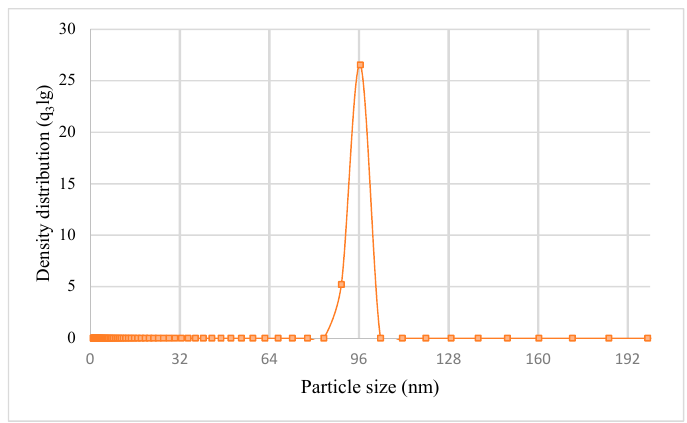
Figure 2. Particle size distribution of 1.0 M ethanolic suspension of commercial 25 nm ZVI-NPs. ZVI@ORMOSIL Synthesis via the Sol-Gel Route